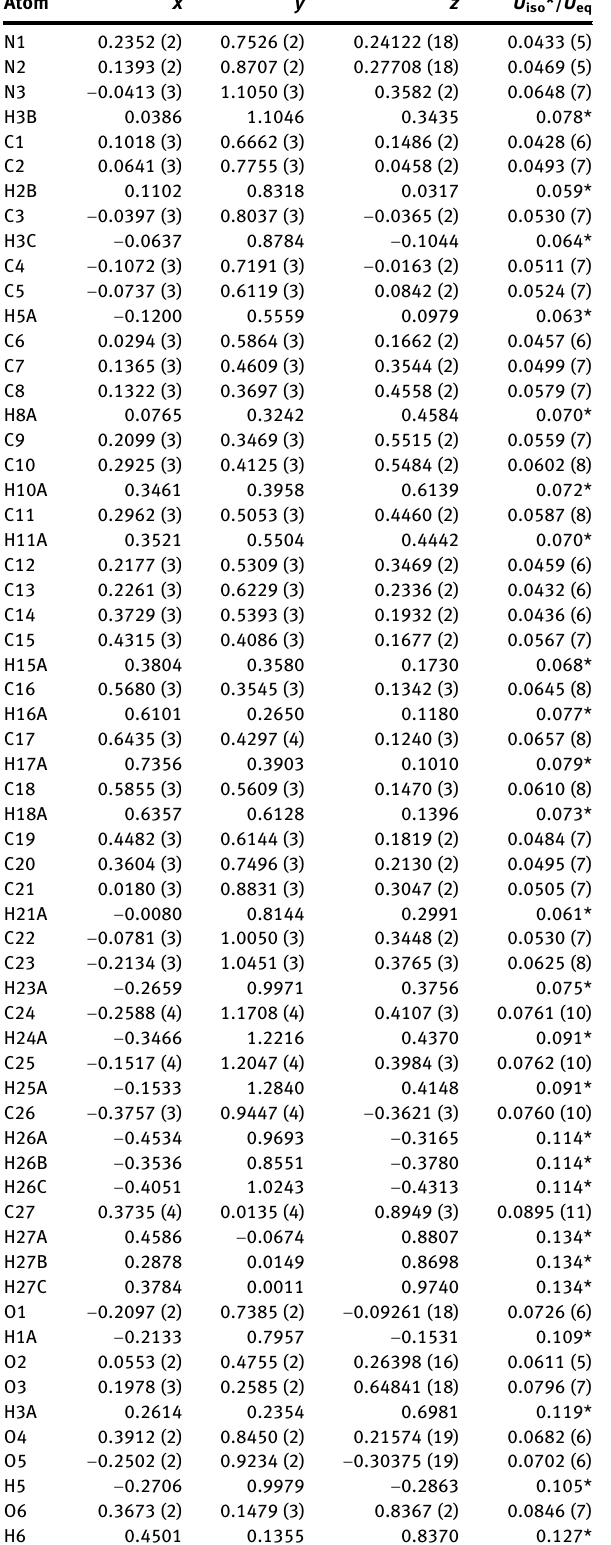
Table  : Fractional atomic coordinates and isotropic or equivalent isotropic displacement parameters (Å 